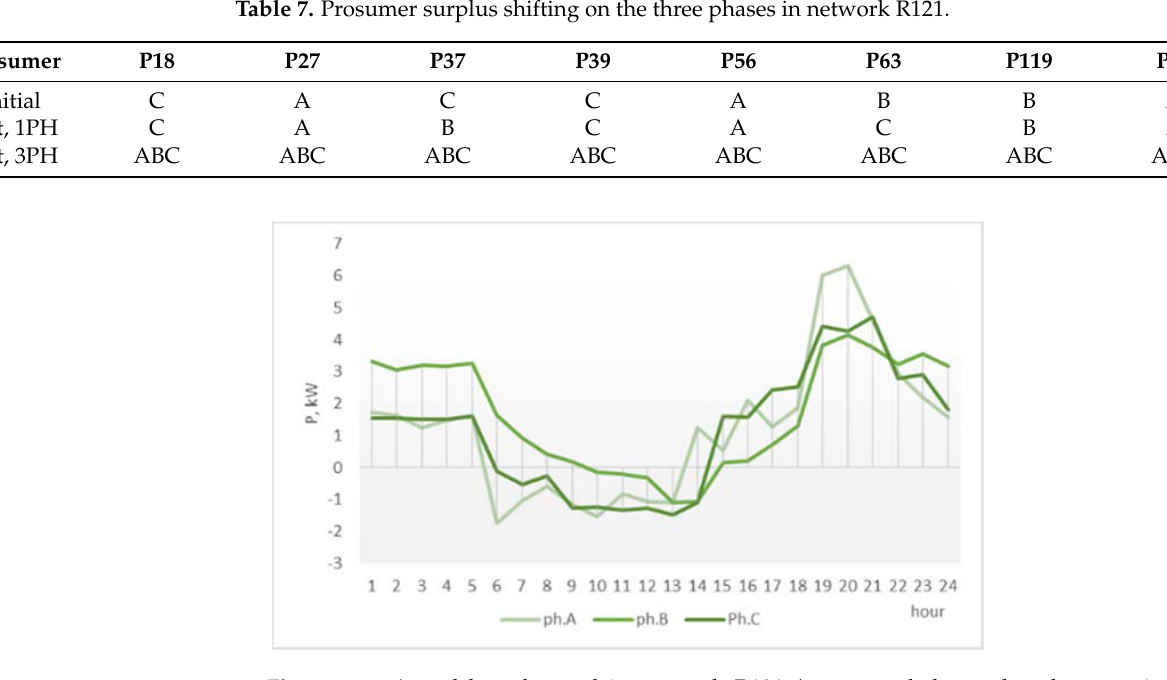
Figure 19. Hourly losses in network R121. As Figures 16–18 show, the initial phase distribution of the prosumers was close to the optimal solution possible with one-phase shifting. By using unbalanced three-phase PSM, the losses were reduced to a significantly lower value, with a 27% drop compared to the initial case. 5. Conclusions The study developed in this paper addresses a problem that is becoming frequent in Romanian residential electricity distribution networks, with the increase in the number of prosumers incentivized by government regulations and subsidy schemes. The newly built residential suburbs usually have high consumption density confined in a narrow area, with microgrid characteristics. The electricity supply infrastructure is sized accordingly and it is able to accommodate a growing number of prosumers. On the other hand, the older networks were designed with lower consumption requirements and supply larger areas with scattered consumption nodes. The proliferation of the prosumers must be managed by network operators considering the proximity of both types of supply, over which the new prosumers must be integrated with minimal negative effects on the economic and technical operation of the electricity distribution infrastructure. The algorithm built by the authors focuses on minimizing the power losses in microgrids with prosumer presence. The study discusses different types of network size,